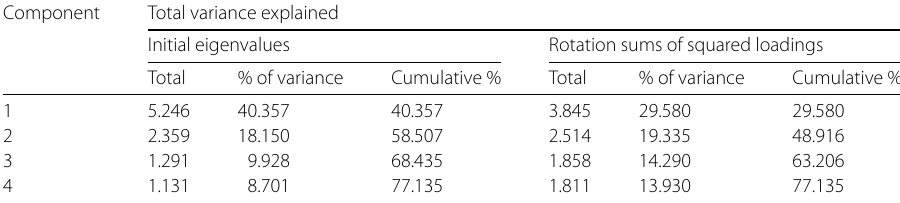
Table 6 Rotation sums of squared loadings